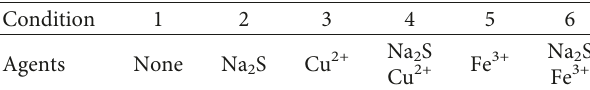
Figure 2: Flowsheet of flotation process. Table 4: Various added agents for the